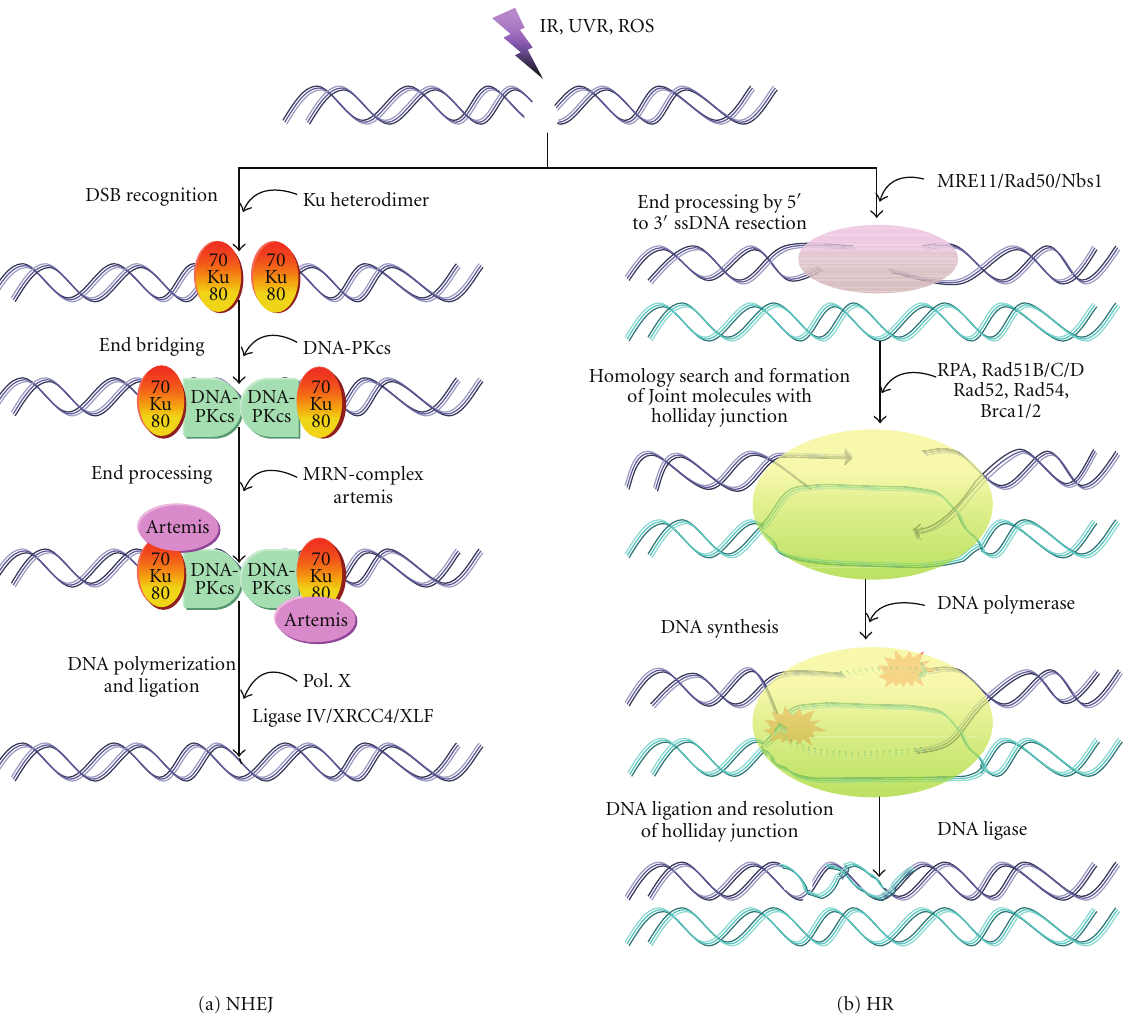
Figure 13: Schematic representation of recombinational repair by (a) non-homologous end joining (NHEJ), and (b) homologous recombination